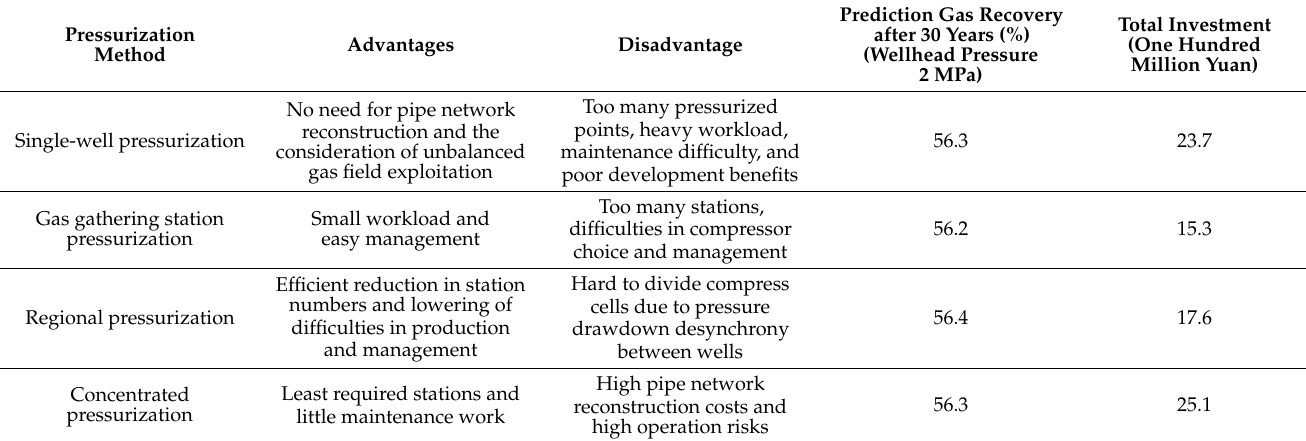
Table 1. Comparison of different pressure-charged